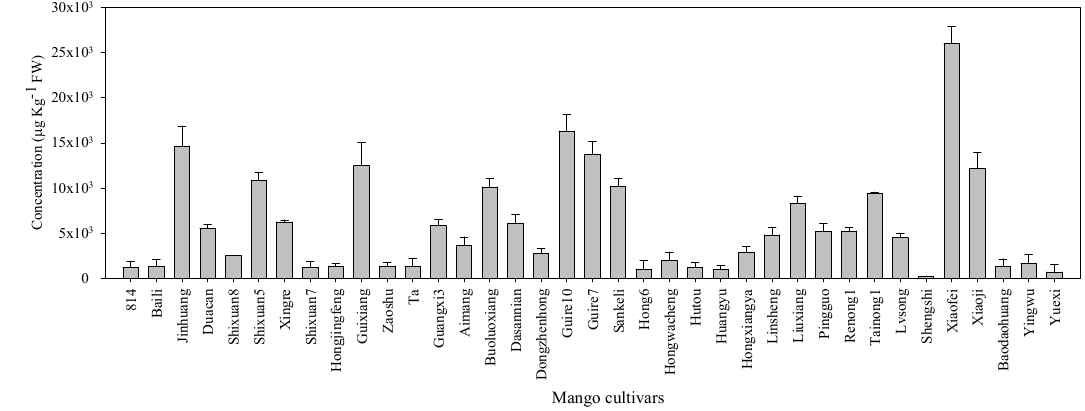
Figure 1. Concentrations (μg kg −1 fresh weight (FW) equivalent of nonyl acetate) of total volatile in 37 mango cultivars.